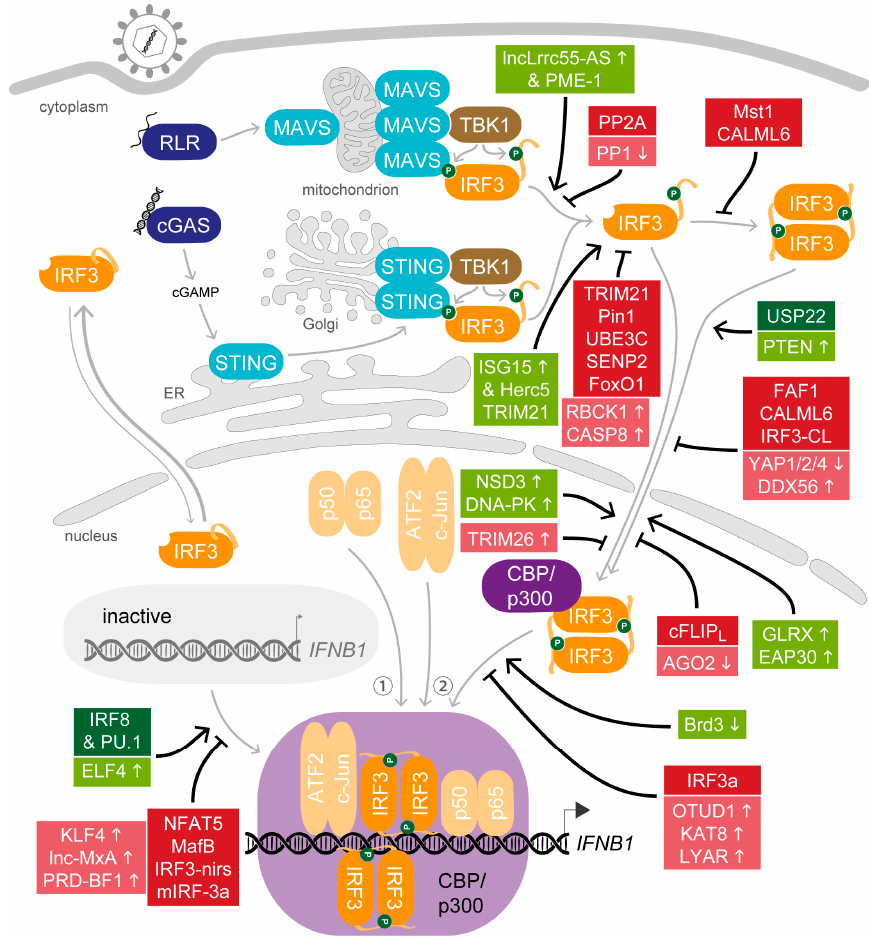
Figure 3. Host modulators of IRF3 activity. Green and red boxes indicate constitutively positive and negative modulators of steps leading to IRF3-mediated IFNB1 expression, respectively. Small arrows mark up- ( ↑ ) or down-regulation ( ↓ ) of the supporting (faded green boxes) or inhibitory (faded red boxes) role of host factors upon activation of antiviral